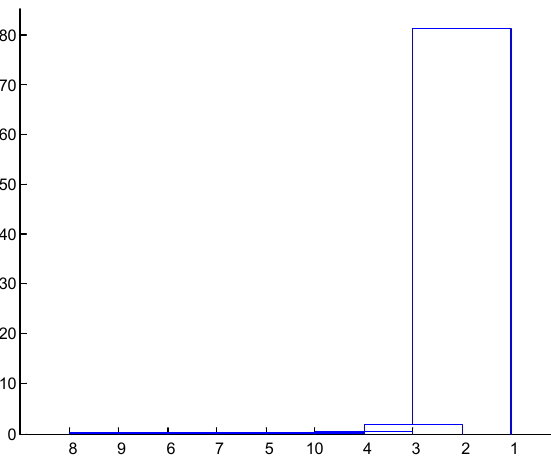
Figure 7. Cluster analysis results of IMFs in Figure 6.